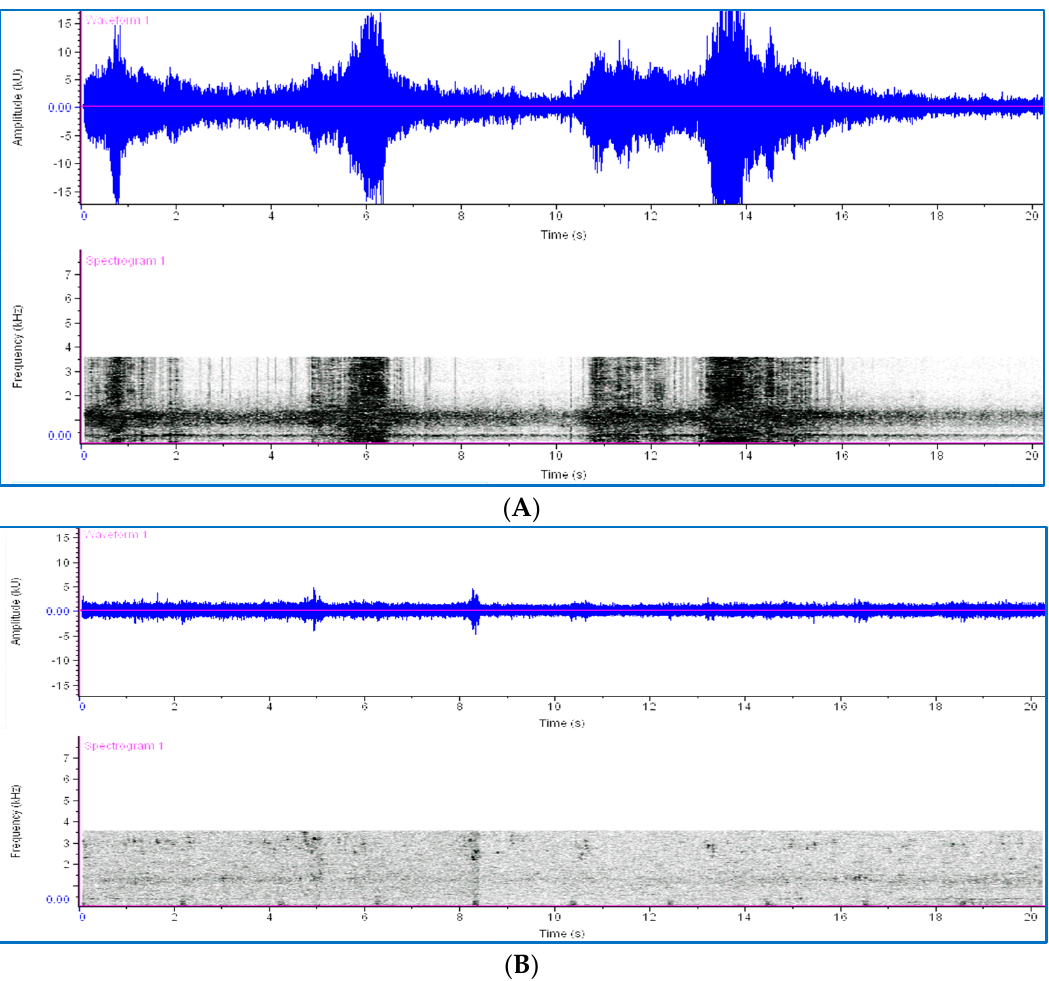
Figure 6. Comparison of background noise spectrograms in the natural environment: ( A ) spectro- grams for wind noise and ( B ) spectrograms for bird noise in the environment. The relative amplitudes (dB) of the RPW larval sounds were recorded for 24 h in an infested date palm, and the signals were divided into morning, afternoon, night, and